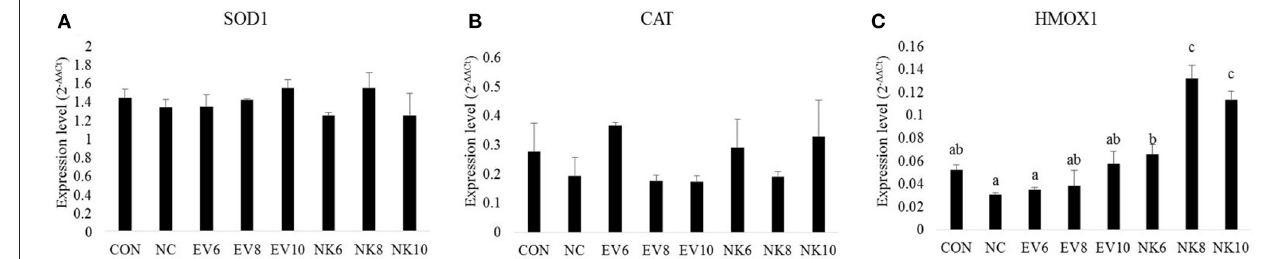
FIGURE 5 | Anti-oxidant gene expression in duodenal mucosa of Eimeria acervulina -infected broiler chickens fed orally Bacillus subtilis expressing cNK-2 (13 dpi). All chickens except CON were infected by oral gavage at day 15 with 5,000 oocysts/chicken of E. acervulina . B. subtilis were administrated by oral gavage at days 14–16. EV, B. subtilis- EV; NK, B. subtilis- cNK-2; NC, E. acervulina infected non -B. subtilis control; EV6, B. subtilis- EV at 10 6 cfu/day; EV8, B. subtilis- EV at 10 8 cfu/day; EV10, B. subtilis- EV at 10 10 cfu/day; NK6, B. subtilis- cNK-2 at 10 6 cfu/day; NK8, B. subtilis- cNK-2 at 10 8 cfu/day; NK10, B. subtilis- cNK-2 at 10 10 cfu/day. Transcript